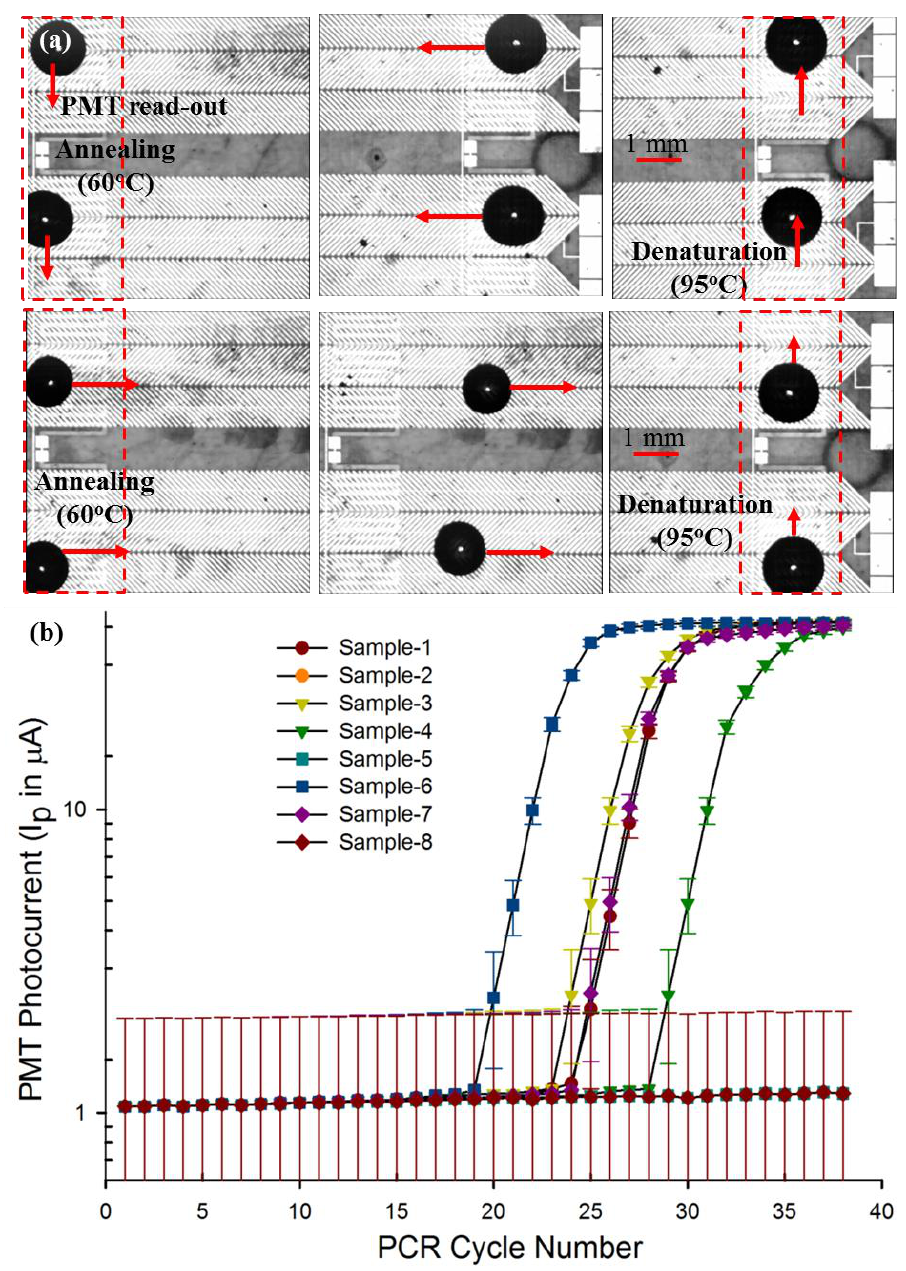
Figure 5. ( a ) Droplet-based parallel, real-time PCR illustrated using two 10-µL PCR droplets; ( b ) qPCR curves extracted from the parallel, multiplex PCR assay (reproduced with permission from